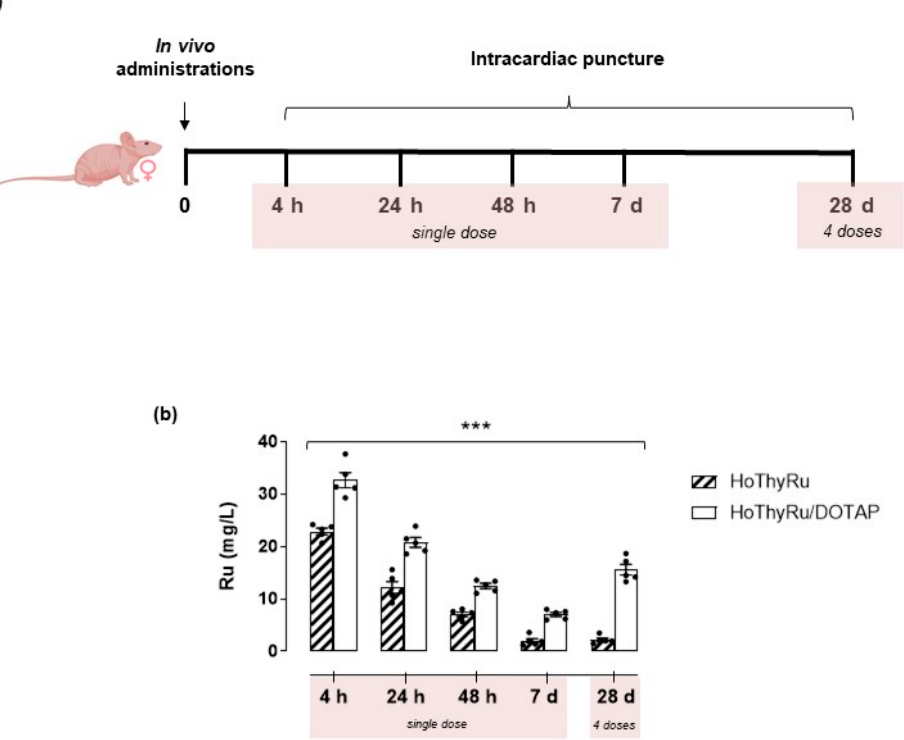
Figure 3. ( a ) Experimental protocol for the preparation of blood samples by intracardiac puncture in nude mice ( n = 5 animals per point) at the indicated times (4, 24, 48 h and 7 days, reported as “single dose”) after a single intraperitoneal administration of HoThyRu (4.5 mg/kg) or HoThyRu/DOTAP (15 mg/kg), or after weekly administrations of HoThyRu (4.5 mg/kg, i.p. ) and HoThyRu/DOTAP (15 mg/kg, i.p. ) once a week for 4 weeks (28 d), re- ported as “4 doses”. ( b ) Evaluation of ruthenium plasmatic levels over time throughout the in vivo study by ICP-MS analysis, as described in the experimental section. Results are plotted in bar graph as mg/L of total ruthenium in mice plasma samples (white bars refer to plasma levels at the indicated times after HoThyRu/DOTAP treatment; ribbed bars refer to plasma levels after HoThyRu treatment). *** p ≤ 0.005 vs. the HoThyRu-treated animal